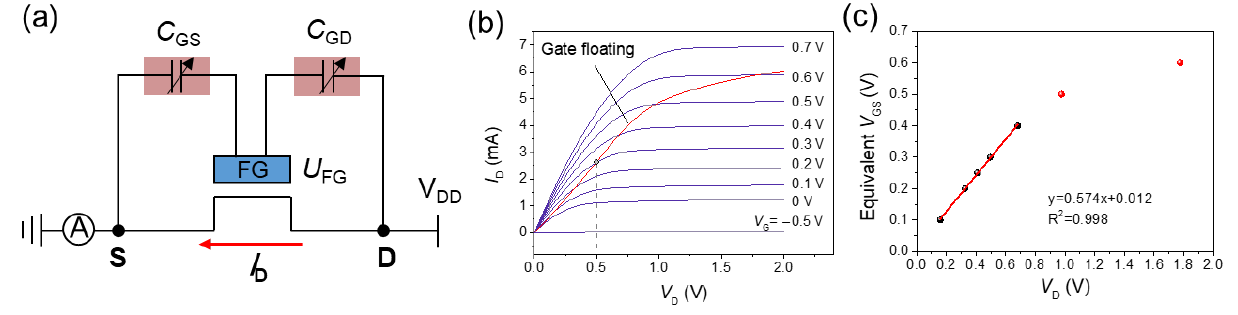
Figure 2. Equivalent circuit of the gas sensor. ( a ) The equivalent circuit diagram of the sensor; ( b ) The I D - V D curve of the field-effect transistor sensor, and ( c ) the relationship between the equivalent gate voltage, V GS , and the drain voltage when the gate is floating.